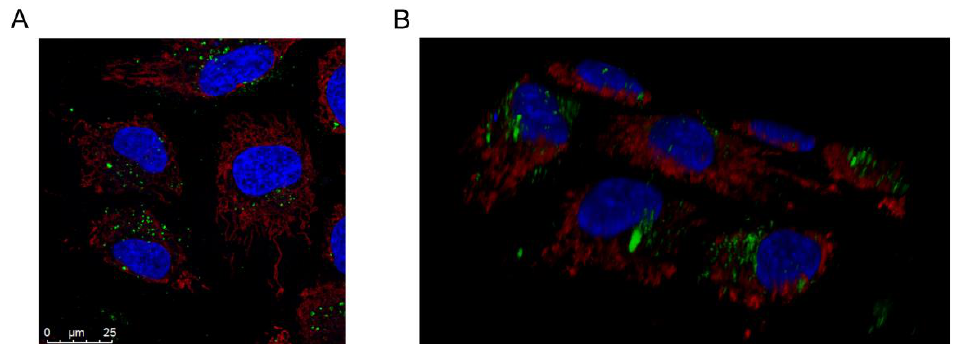
Figure 4. PalmNG EVs internalized by Huh-7 cells localize predominantly to the perinuclear area. Huh-7 cells were incubated with MJSpalmNG-derived EVs for 6 h at 37 °C, followed by mitochondria and nucleus staining with MitoTracker Red and Hoehst 33342, respectively, and imaging by confocal microscopy. ( A ) A representative single Z-stack image; ( B ) a 3D reconstruction of the confocal Z-stack images. See Supplementary video S1 for the reconstructed confocal Z-stack image animation.